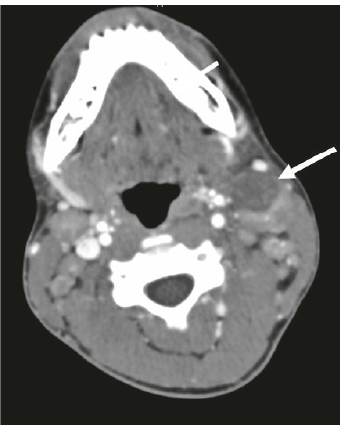
Figure 3: Coronal CT angiogram of the neck demonstrating extensive hypervascularity of cervical lymph nodes bilaterally which are more pronounced on the left side.